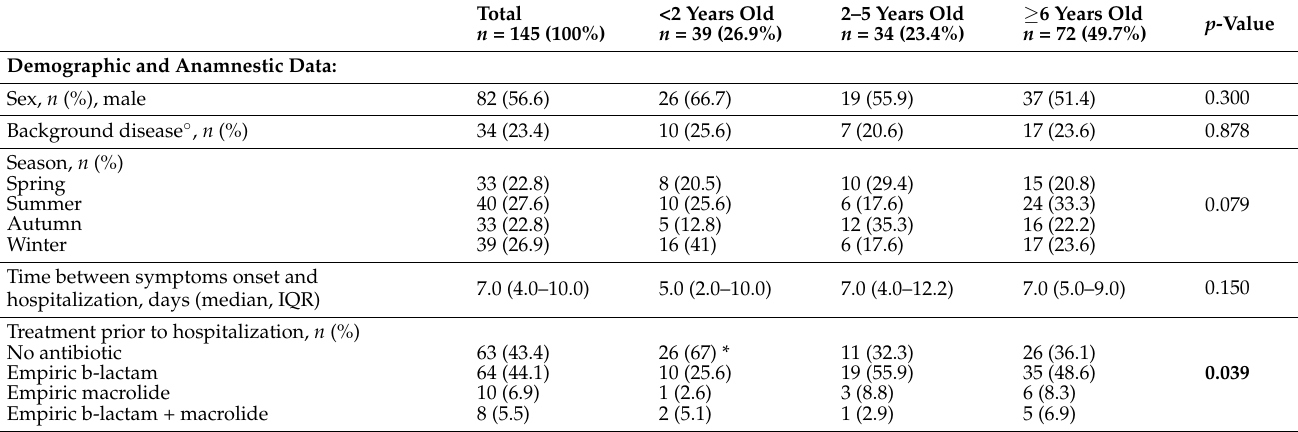
Figure 2. Distribution of positive MP tests during the study period. ( A ) Number of positive MP tests by months of the year. ( B ) Percent of positive MP PCR tests by year. Table 1. Demographic, and laboratory and clinical data of the study